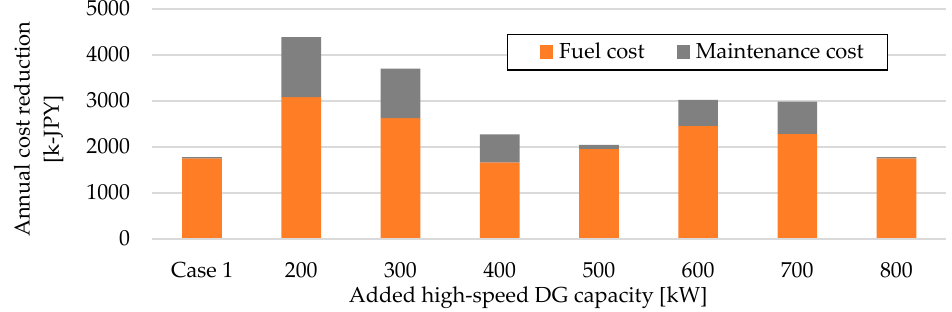
Figure 10. The annual cost reduction effect of Case 1 and Case 3 in comparison with Case 0.